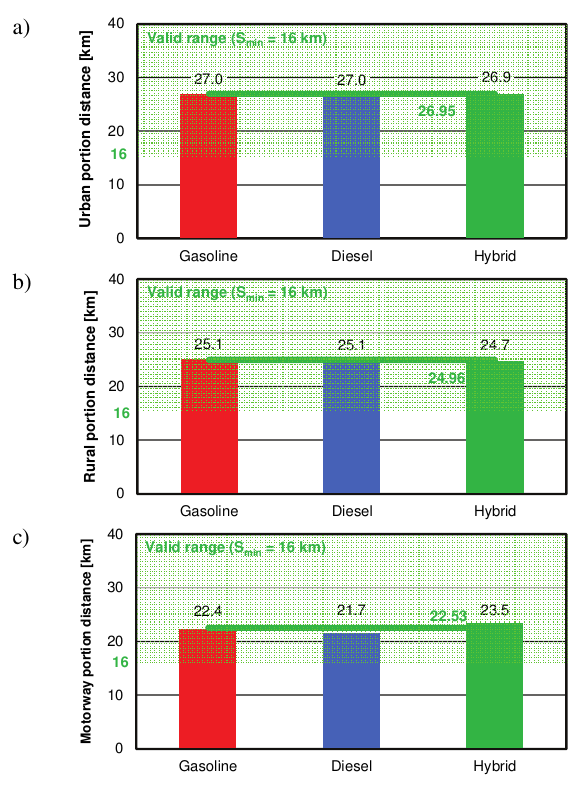
Fig. 6. Travel distance comparison of urban (a), rural (b) and motorway (c) test drives with the minimum distance (required) and the mean value for all vehicles